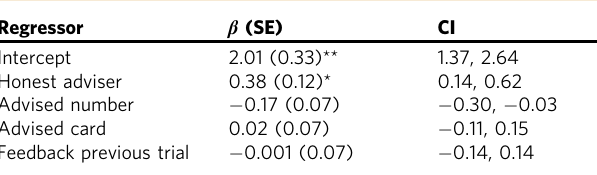
Table 1 Mixed-effects logistic regression analysis of advice- taking behavior